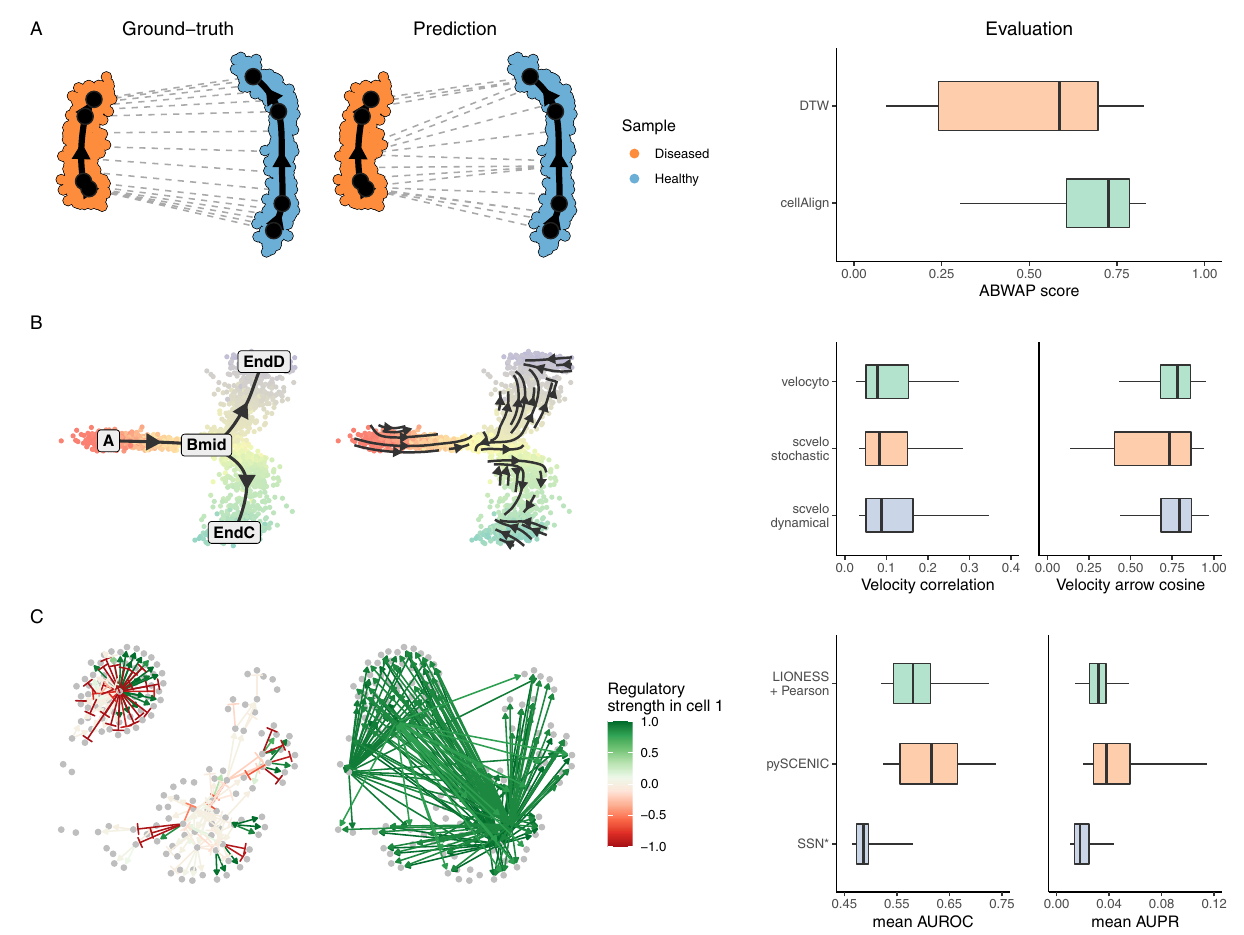
Fig. 2 dyngen provides ground-truth data for a variety of applications (left), which can be used to quantitatively evaluate methods (right). Box plots denote the Q 0 to Q 4 quartile values. A Trajectory alignment aligns two trajectories between samples. We evaluate Dynamic Time Warping (DTW) and cellAlign when aligning two linear trajectories with different kinetic parameters based on the area differences between the worst possible alignment and the predicted alignment (Area Between Worst And Prediction, or ABWAP). B RNA velocity calculates for each cell the direction in which the expression of each gene is moving. We evaluated scVelo and velocyto by comparing these vectors with the known velocity vector (velocity correlation) and with the known direction of the cellular trajectory in a dimensionality reduction (velocity arrow cosine). C Cell-speci fi c network inference (CSNI) predicts the regulatory network of every individual cell. We evaluate each cell-speci fi c regulatory network with typical metrics for network inference: the Area Under the Receiver Operating Characteristics-curve (AUROC) and Area Under the Precision-Recall curve (AUPR). We evaluate three CSNI methods by computing the mean AUROC and AUPR across all